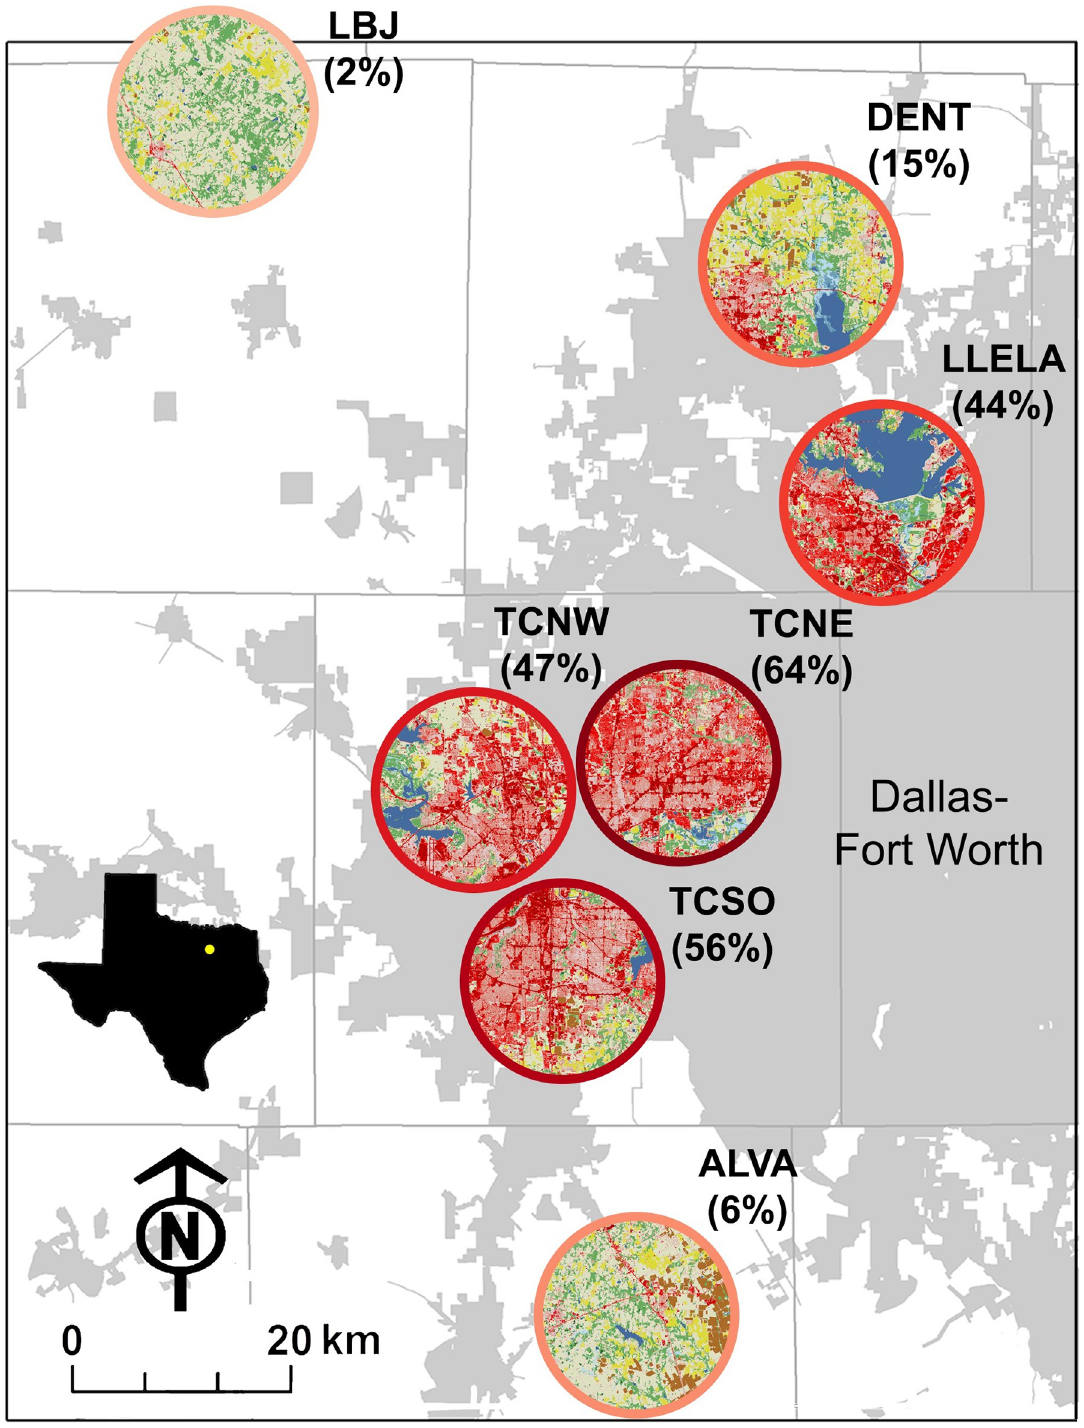
Fig 1. Study area map. Sites where bulk inorganic N deposition was measured in the Dallas-Fort Worth metropolitan area (municipal areas in grey) and the L.B.J. National Grasslands National Atmospheric Deposition Program (NADP) site. Percent urban development within a 10-km radius buffer [39] is indicated in parentheses and ranges from low (light pink border) to high (crimson red border).